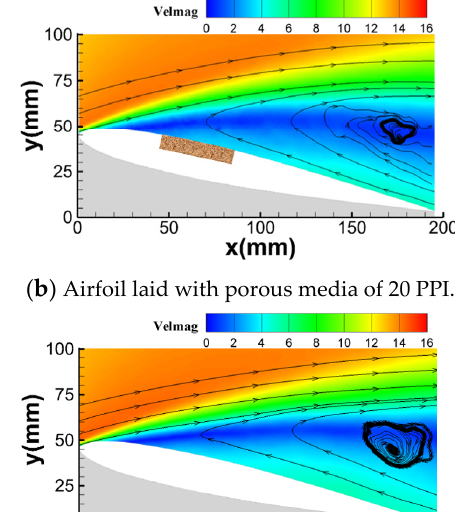
Figure 7. Time-averaged results of velocity field (AOA = 6).